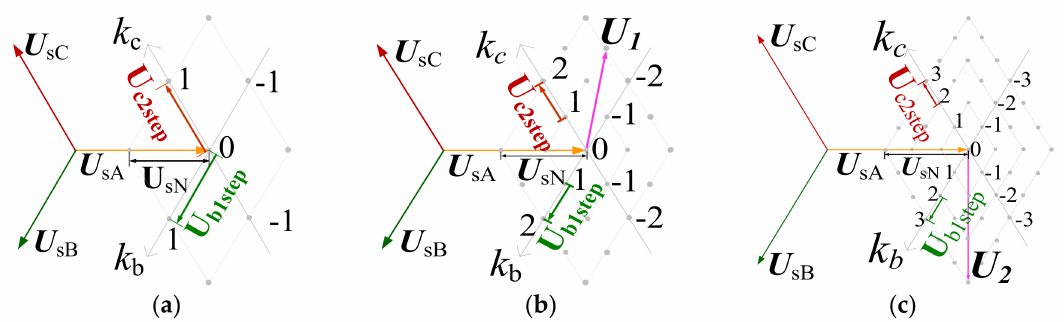
Figure 4. HVST output voltage phasors ( U HVSTA ) with different tap numbers. ( a ) (0, ± 1) level; ( b ) (0, ± 1, ± 2) level; ( c ) (0, ± 1, ± 2, ± 3) level.